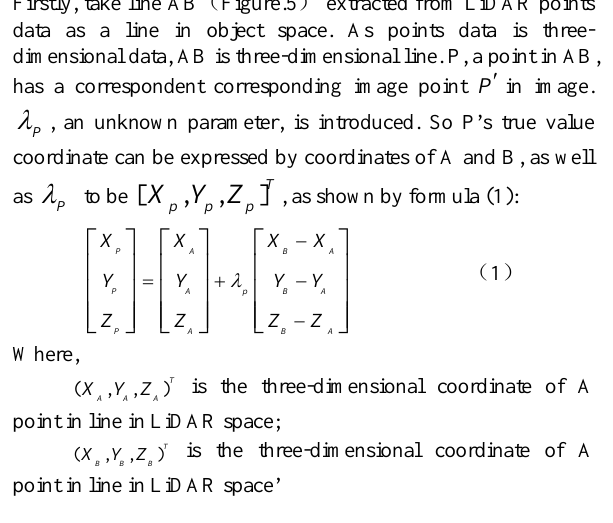
Figure3- The formulation of the feature voxel